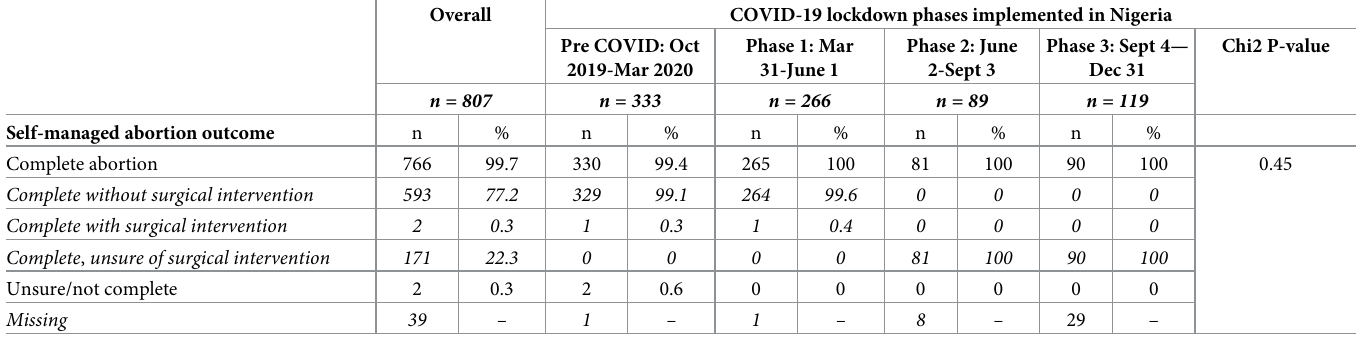
Table 4. Abortion completion following self-managed medication abortion among people who contacted a safe abortion accompaniment group in Lagos, Nigeria in 2019–2020.